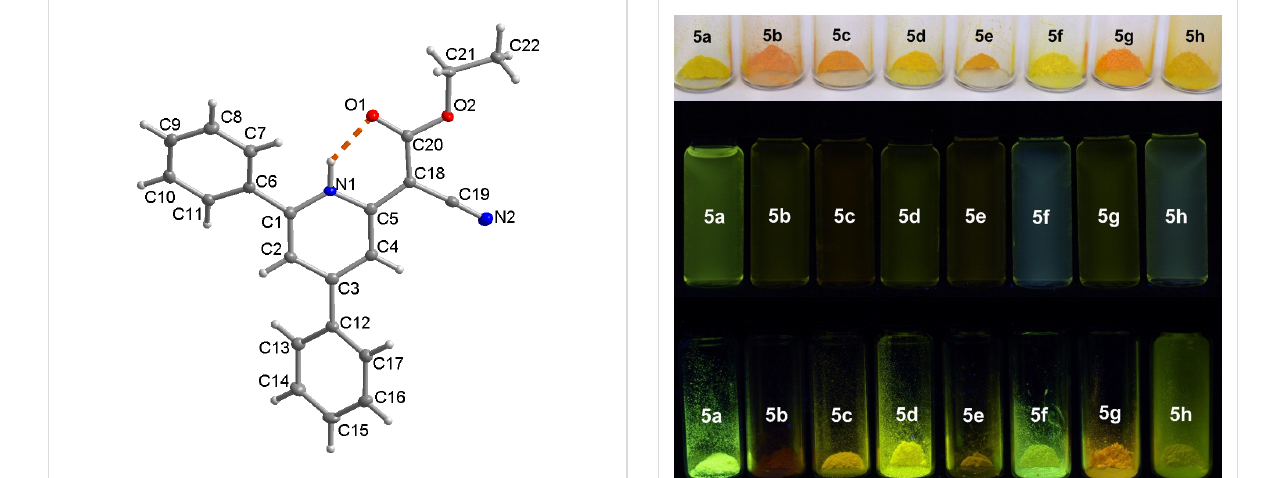
Figure 1: Molecular structure of 1 H -pyridine 5a (50% thermal ellip- soids), showing the intramolecular N–H···O bond as dashed orange line. H-bond details N1–H 0.90(2) Å, H···O1 1.87(2) Å, N1···O2 2.624(2) Å, O1–H···O2 140(1)°.